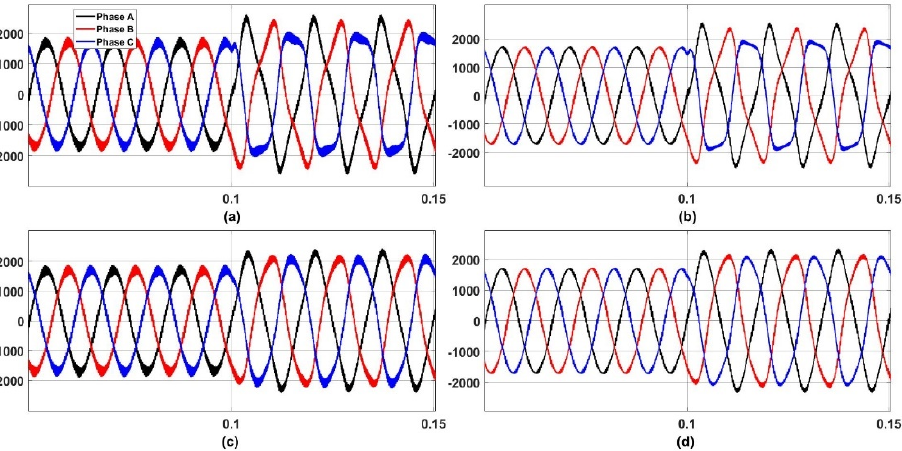
Figure 23. Three-phase pcc currents in an unbalance dip in the case of ( a ) 2L- αβ , ( b ) 3L- αβ , ( c ) 2L-dq and ( d ) 3L-dq .